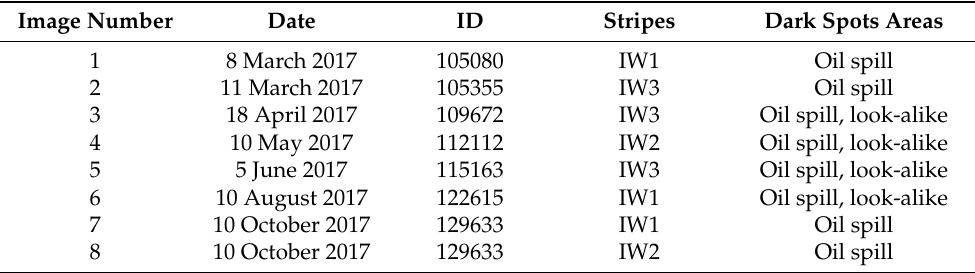
Table 2. Sentinel-1 data used in experiments.